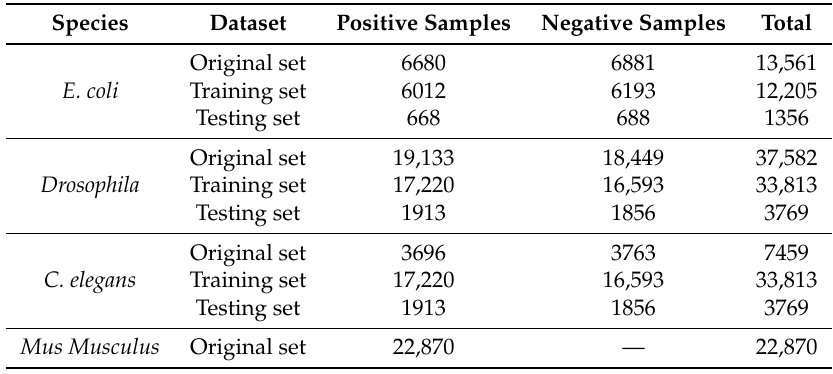
Table 3. Protein–protein interaction (PPI) datasets for four